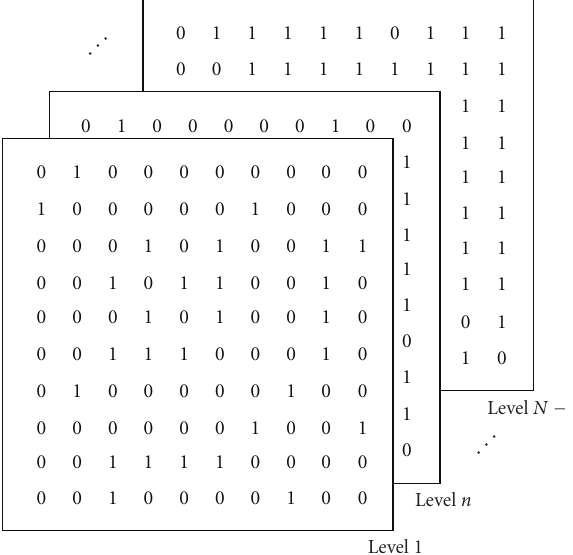
Table 2: Fitness function